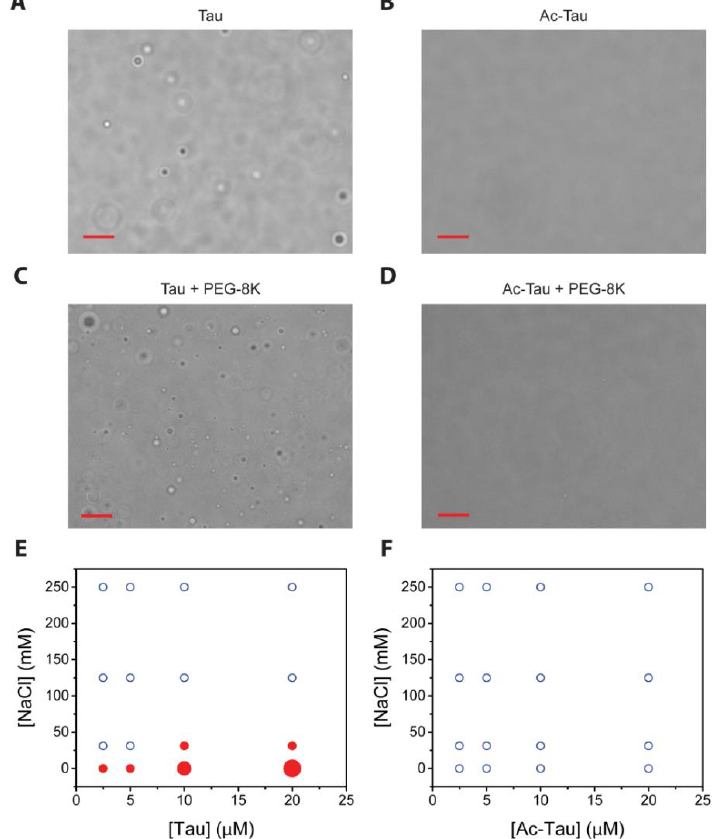
Figure 2. Acetylation disfavors Tau liquid-liquid phase separation (LLPS). Droplet formation of wt Tau versus hyperacetylated (Ac-Tau), respectively, in the absence ( A , B ) and presence of the crowding agent PEG-8K ( C , D ). Phase transition maps of Tau versus Ac-Tau (in the absence of crowders), respectively ( E , F ). The diagrams present protein and salt concentration dependencies of droplet formation. Blue open circles represent conditions of minimal droplet formation (<5 droplets/frame); small red solid circles represent 5 – 20 droplets, medium red solid circle 20 – 100 droplets, and large red circle >100 droplets. The bars in ( A – D ) represent 10 µm. See Section 3 for details.